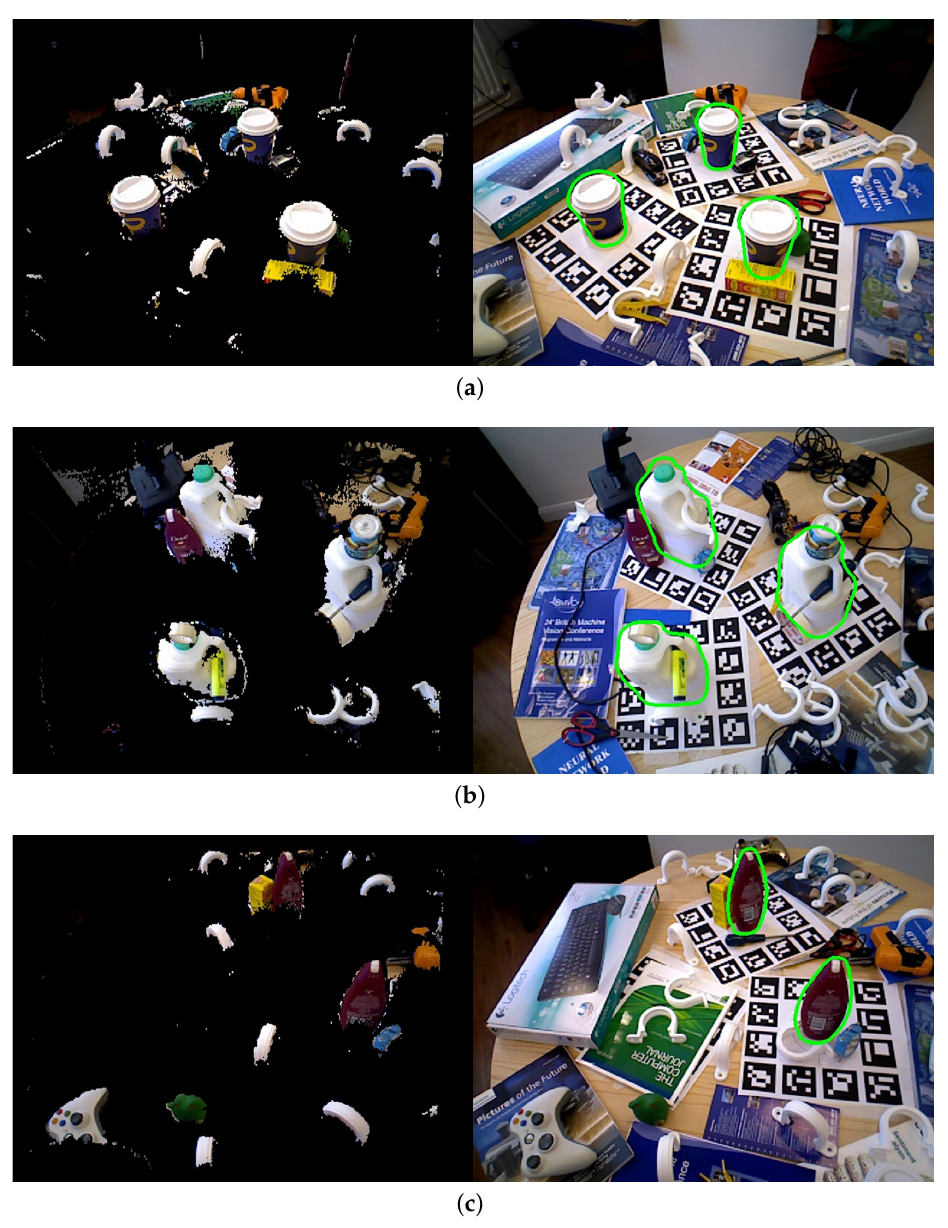
Figure 13. Our detection on ( a ) coffee ( b ) milk; ( c ) shampoo of Tejani dataset. ( Left ) image after scene preprocessing; ( Right ) detection result. The green points show the detection